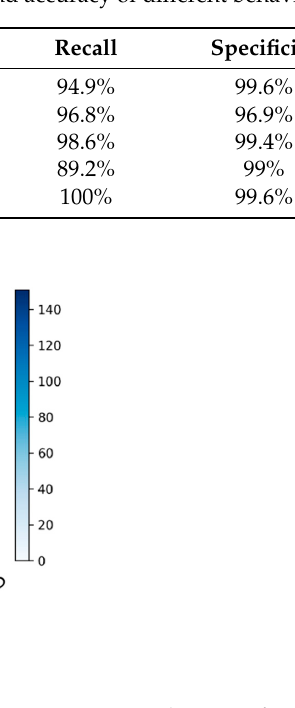
Figure 7. Confusion matrix results. Behaviors 1–5 represent hypoxia, feeding, frightening, hypo- thermia, and normal behaviors, respectively.